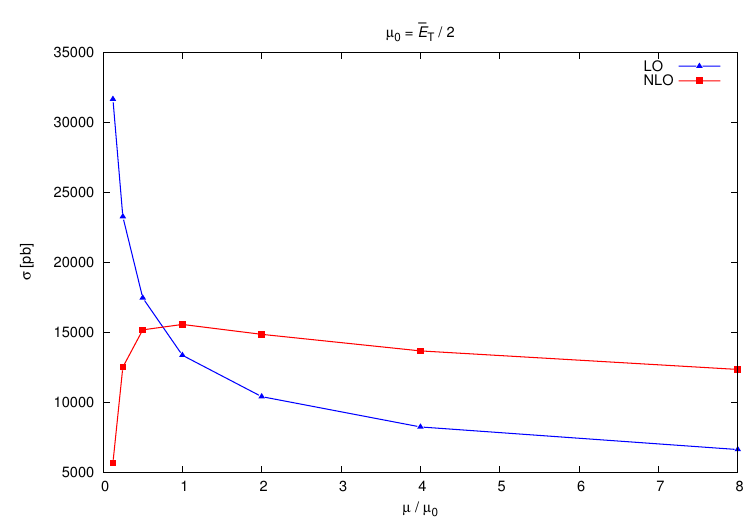
Figure 4. Scale dependence of the LO and NLO cross sections at a centre-of-mass energy p s = 13 TeV at the LHC for pp (cid:22) (cid:0) (cid:22) (cid:23) (cid:22) b(cid:22)bjj. The renormalisation and factorisation scales are varied ! together around the central scale (cid:22) 0 = E T = 2 de(cid:12)ned in eq. (4.1). a factor four) when going from LO to NLO accuracy. The asymmetric scale uncertainty at NLO is due to our choice of the central scale near the maximum of the cross section.